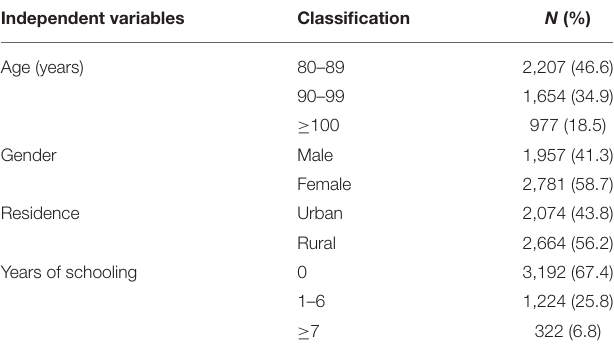
TABLE 1 | Descriptive characteristics of the study